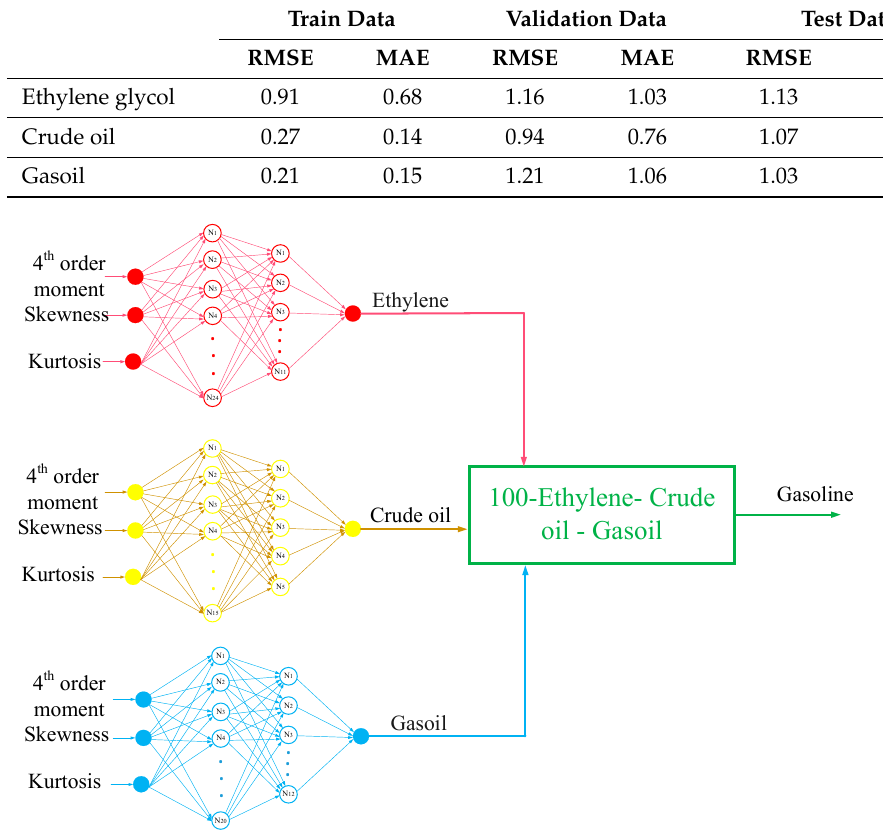
Figure 9. The general process of recognizing the volume ratio of every oil product.